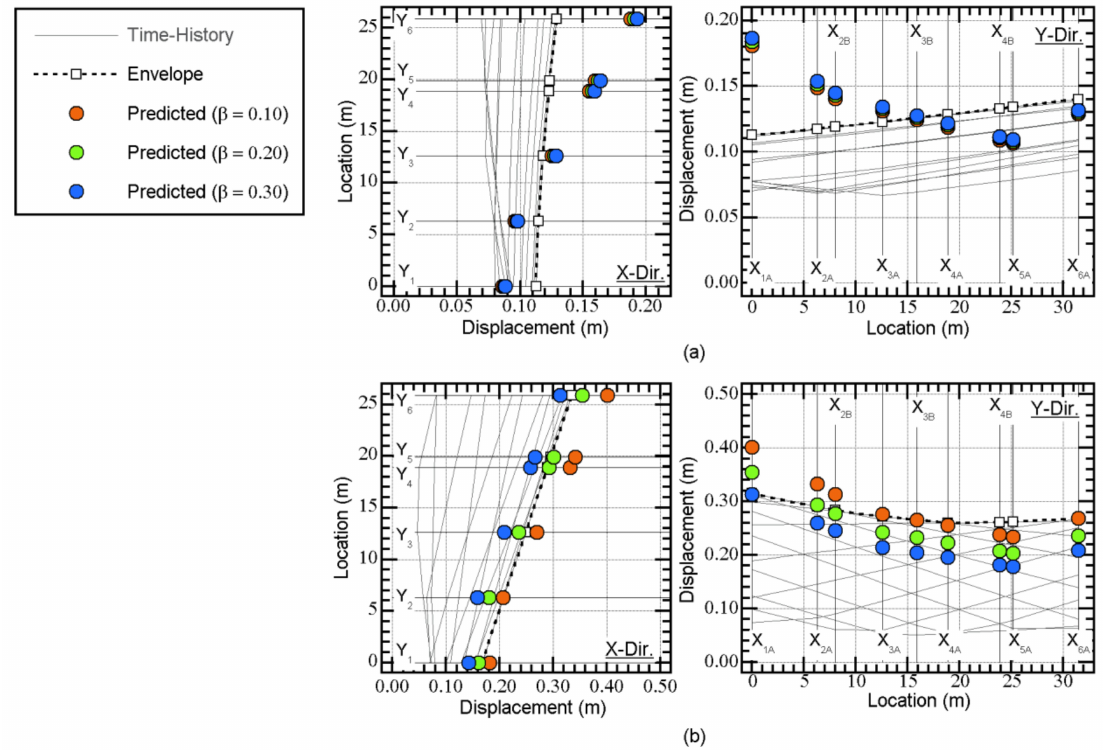
Figure 26. Comparison of the horizontal distributions of the peak displacement at level 0 (model: Model-Tf34) for ( a ) UTO0414 and ( b )